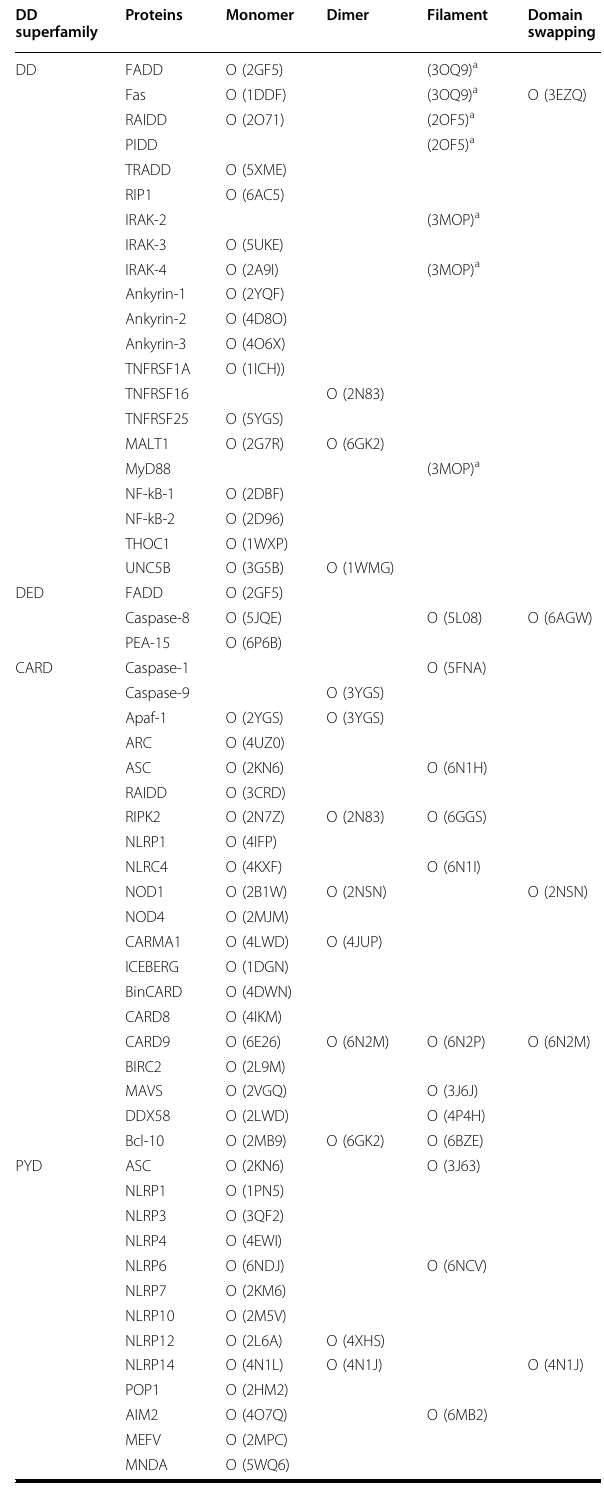
Table 1 Structures of various forms of DD